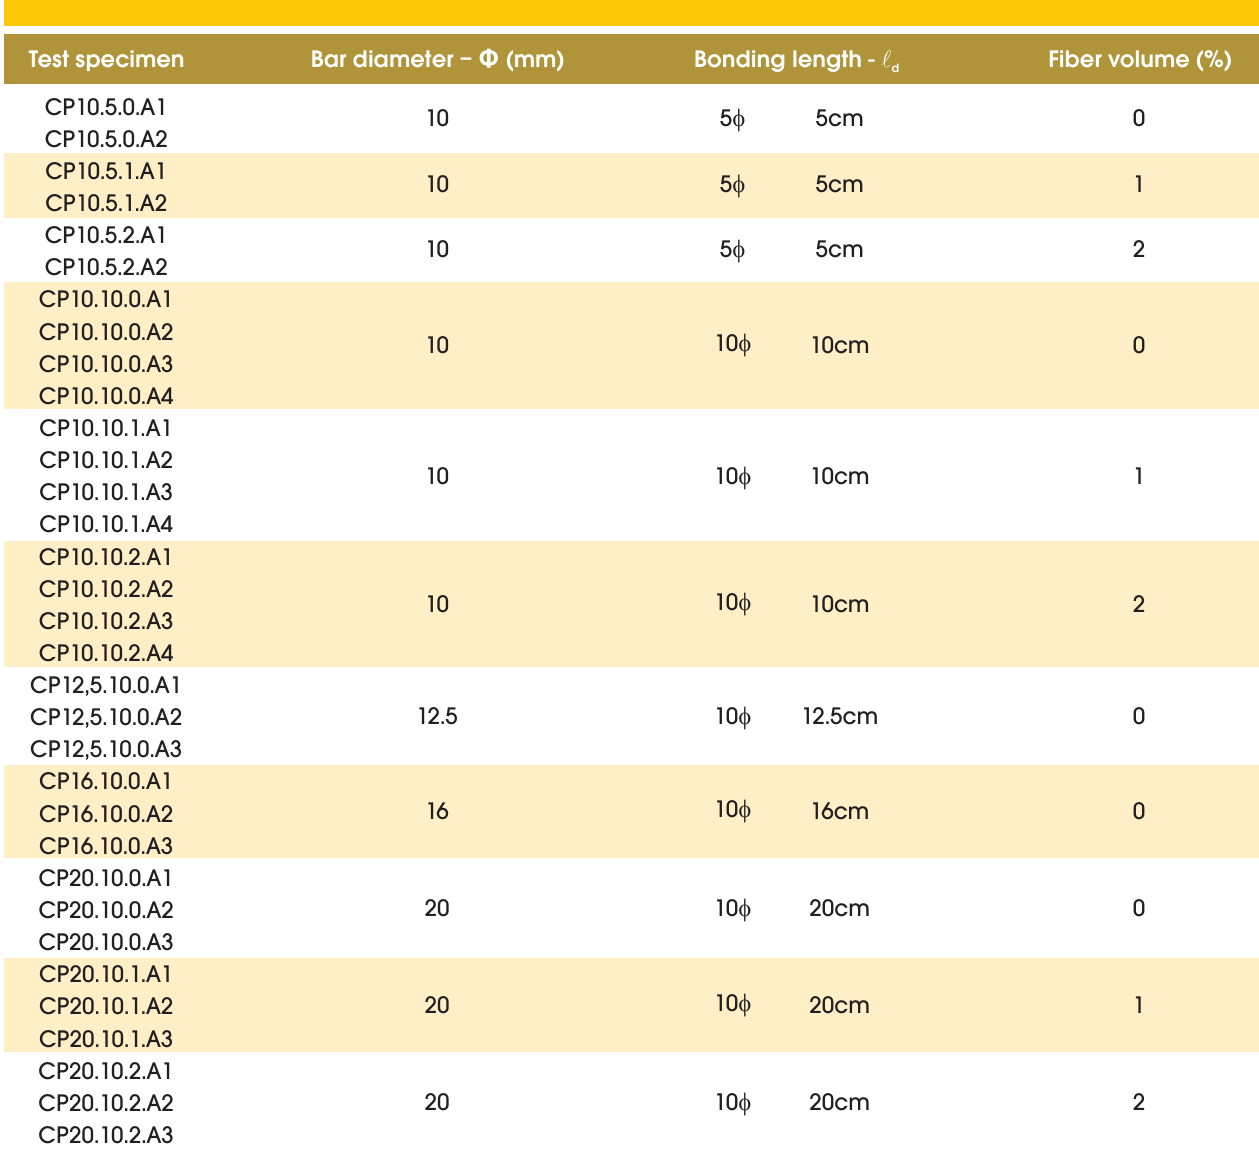
Table 1 – Variables of pull-out and splitting